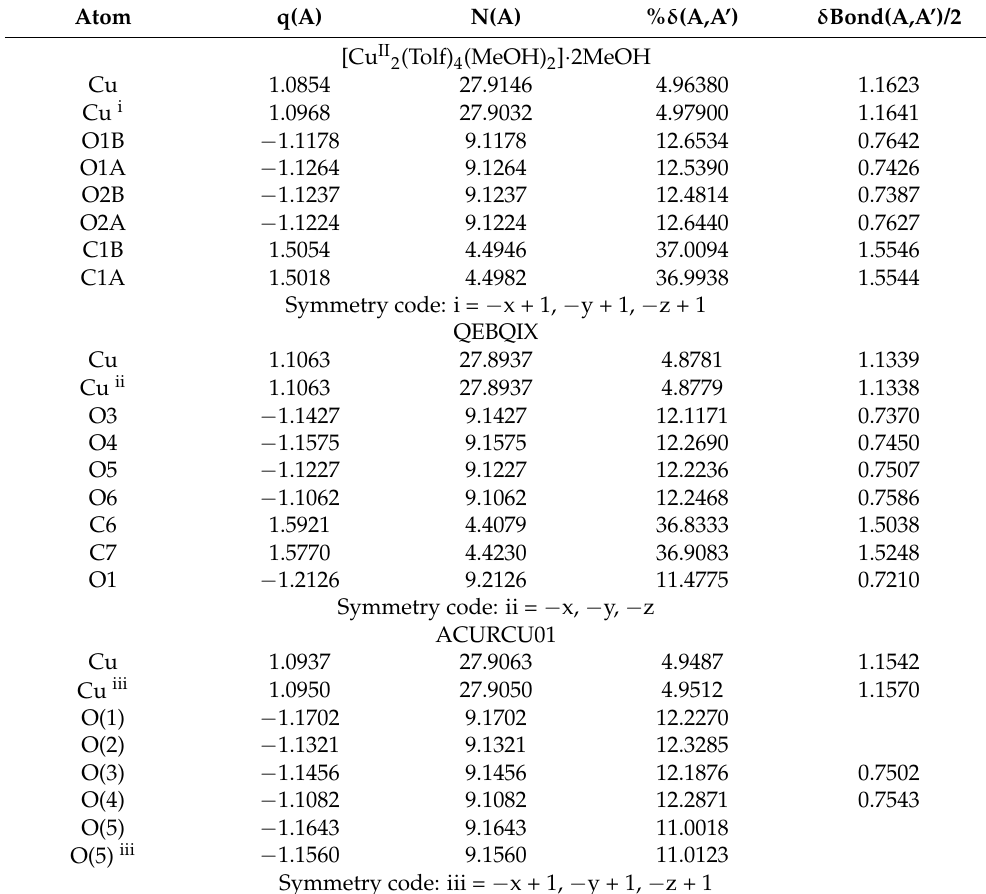
Table 6. QTAIM parameters for the selected atomic basins for [Cu II 2 (Tolf) 4 (MeOH) 2 ] · 2MeOH, QE- BQIX, and